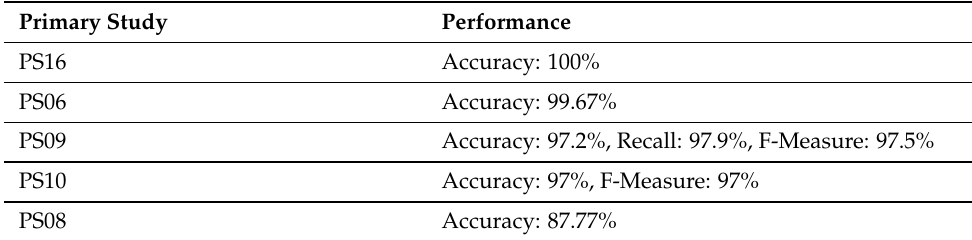
Table 9. Top five studies based on the results of the performance